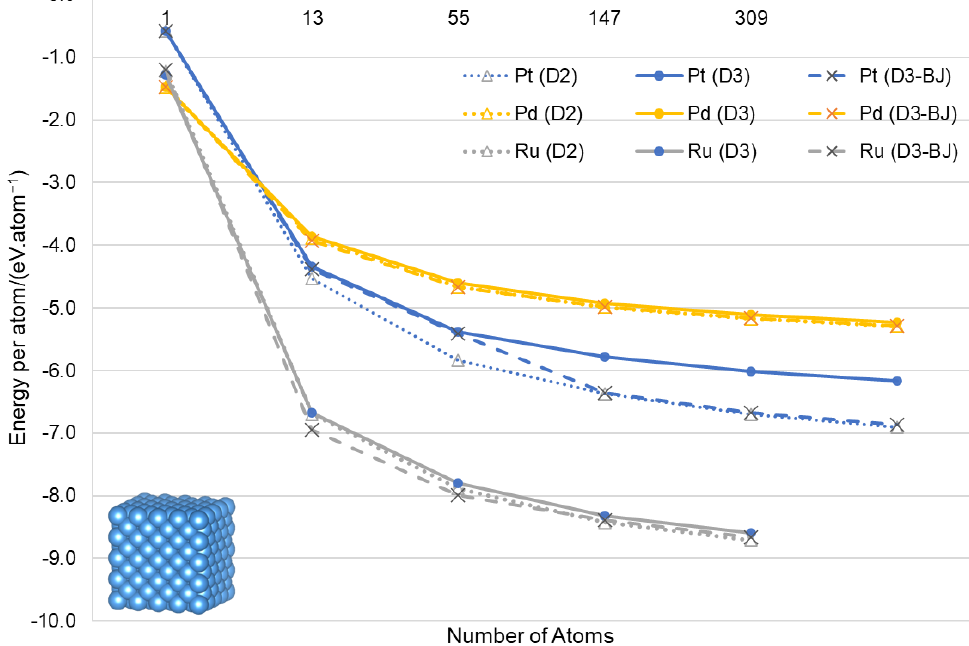
Catalysts 2022 , 12 , x FOR PEER REVIEW Figure 6. Energy per atom as a function of size for cubic Ru, Pd and Pt nanoparticles calculated with the three modelling methods, DFT-D2, DFT-D3 and DFT-D3(BJ). The most stable configurations in terms of energy per atom versus the number of atoms for spherical Ru, Pd and Pt nanoparticles of increasing sizes, calculated with the three DFT-D2, DFT-D3 and DFT-D3(BJ) modelling methods, are shown in Figure 7. Due to the incremental increase in radius of the theoretical spherical size considered, more structures were calculated. However, calculating the surface-to-bulk atom ratio is not the same as with the other nanoparticles, because each increment in size does not necessarily add a full shell to the particle. As expected, a decreasing trend of the surface-to-bulk ratio is still observed: 12.00, 18.00, 2.31, 3.23, 5.08, 0.58, 1.45, 1.56, 1.03, 0.49, 0.67 (0.84) and 0.60 for G m = 13, 19, 43, 55, 79, 87, 135, 141, 177, 201, 255 (249) and 321, respectively. Surpris- ingly, the overall energy per atom starts at a much higher energy than was observed for the other nanoparticles, but as in the other nanoparticles, the energies extrapolate to − 5, − 6 and − 8 eV/atom for Pd, Pt and Ru, respectively.